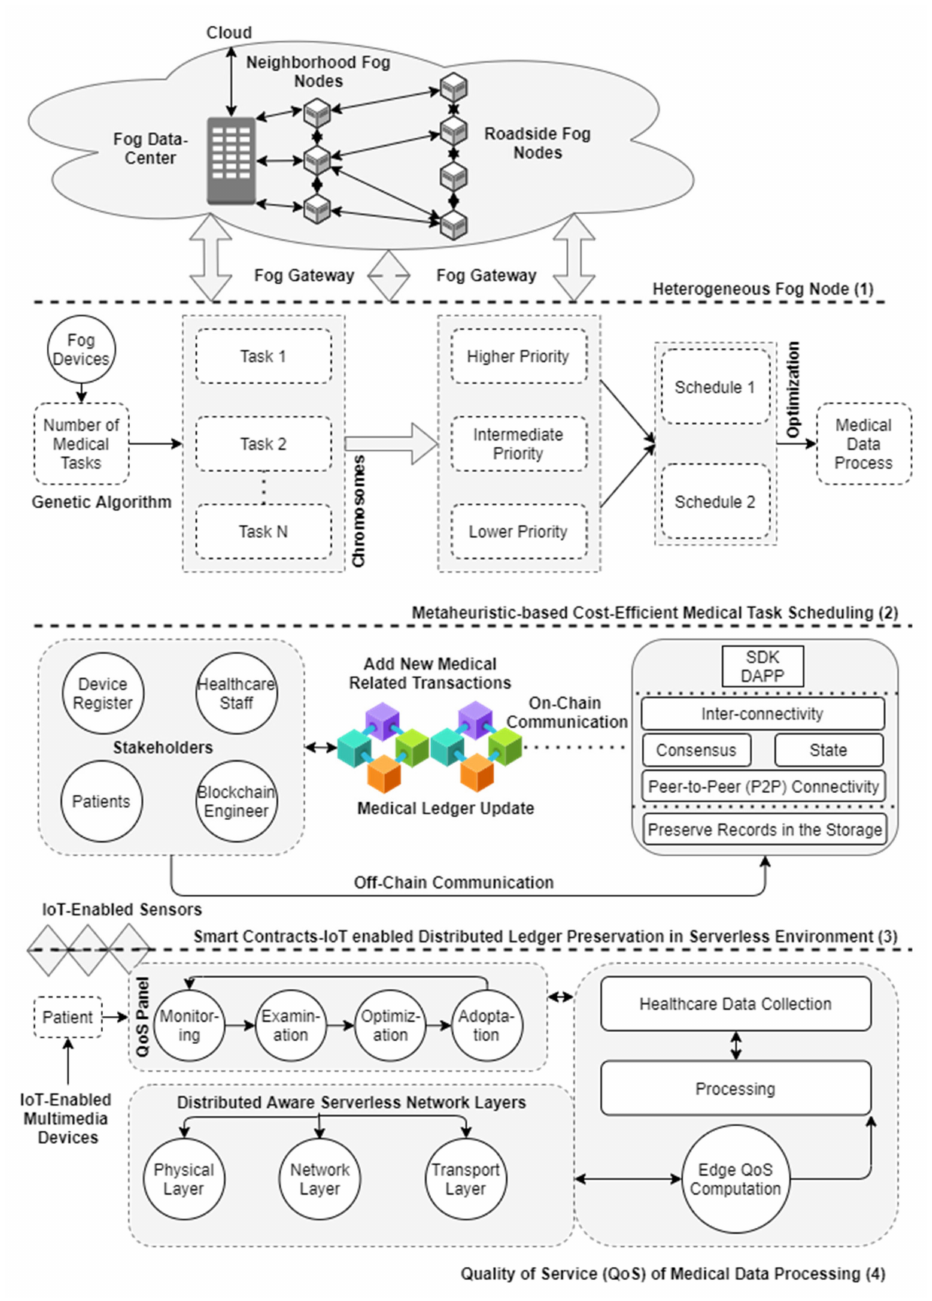
Figure 3. The proposed QoS-ledger